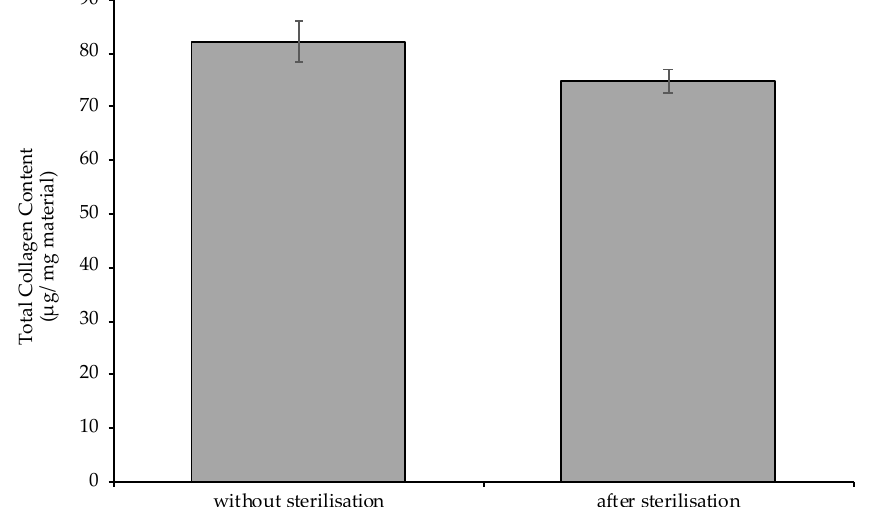
Figure 4. Total collagen content in dECM powder obtained with the use of the most preferable variant (i.e., ground/PBS/4 °C) without sterilization (i.e., before sterilization; left graph bar) and after sterilization (right graph bar); MV ± SD, n = 4, p = 0.0230.